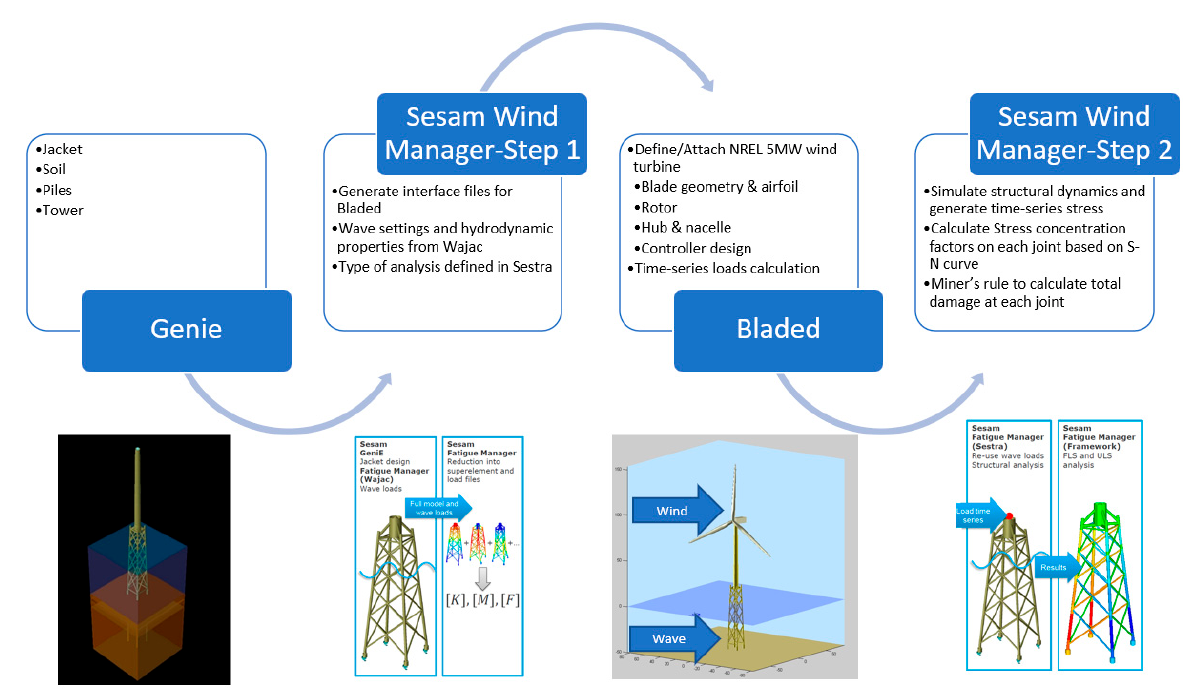
Figure 10. Hotspots of K-joint [44].